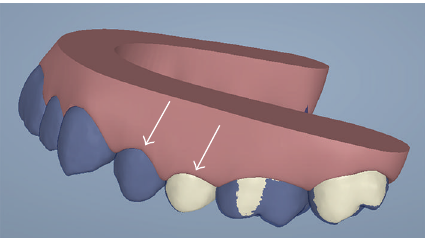
Figure 1: Invisalign ClinCheck allows to predict dental movement with a very high precision, comparing every single element. This is an example of drowning: the first premolar coloured in blue is the control site and the second premolar is the test site. The blue color represents the position of the tooth before movement and the white one is the element subjected to dental flaring.